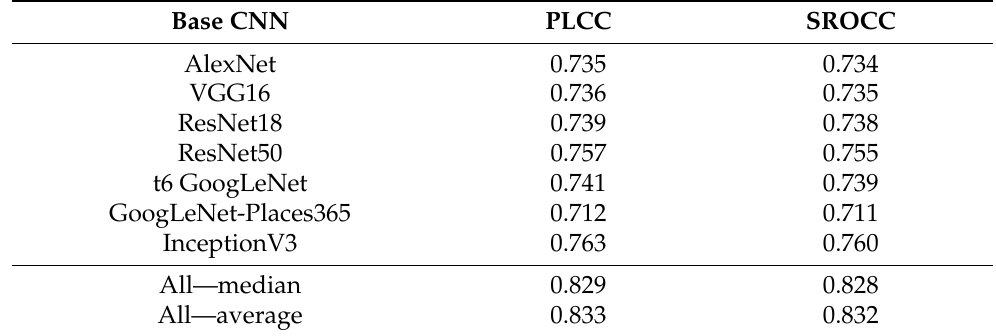
Table 5. Performance of different base architectures and decision fusion methods using GAP layers for feature extraction and SVRs with Gaussian kernel function for regression. Median PLCC and SROCC were measured over 1000 random train–test splits.